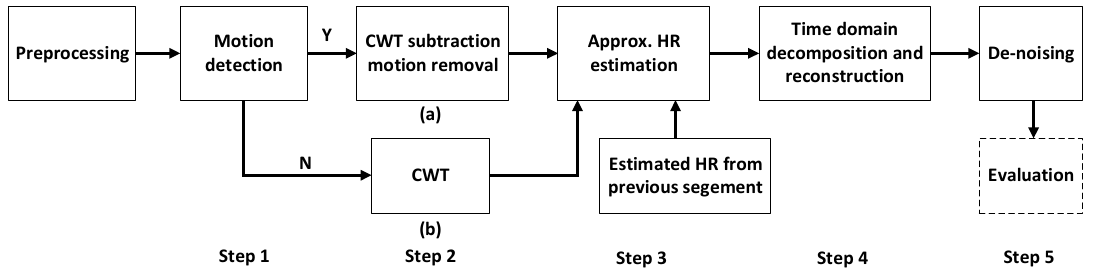
Figure 6. The proposed algorithm framework for MAR based on two wavelengths including five steps.